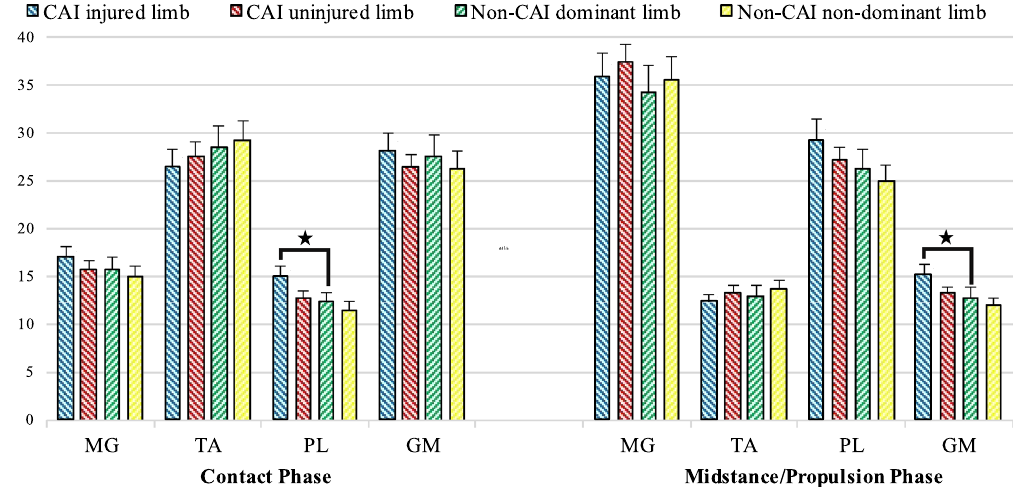
Figure 2. Average and standard division of muscles activity in CAI and Non-CAI groups during walking. CAI Chronic ankle instability, MG Medial gastrocnemius, TA Tibialis anterior, PL Peroneus longus, GM Gluteus medius. *Significant different between the